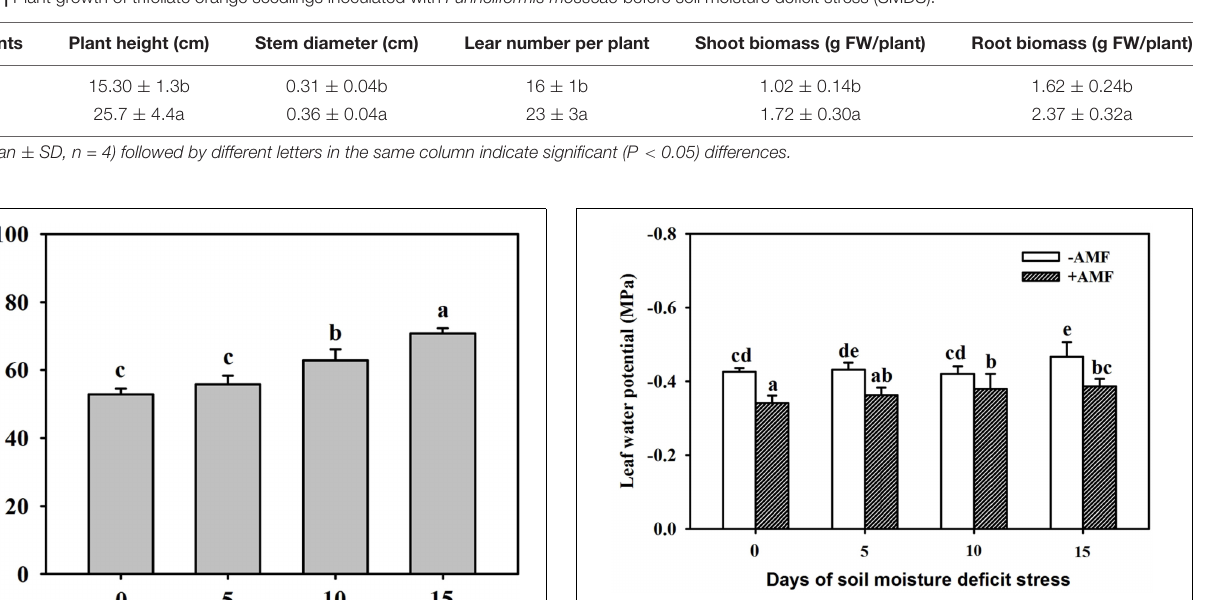
stem diameter, leaf number per plant, shoot biomass, and root biomass by 68%, 16%, 44%, 69%, and 46%, respectively, before SMDS began ( Table 1 ).